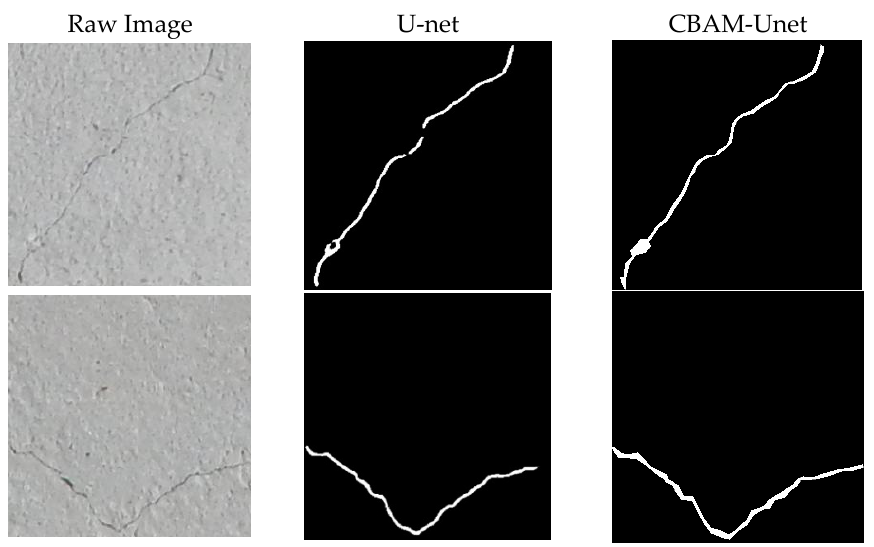
Figure 15. Results of two methods for shallow cracks.